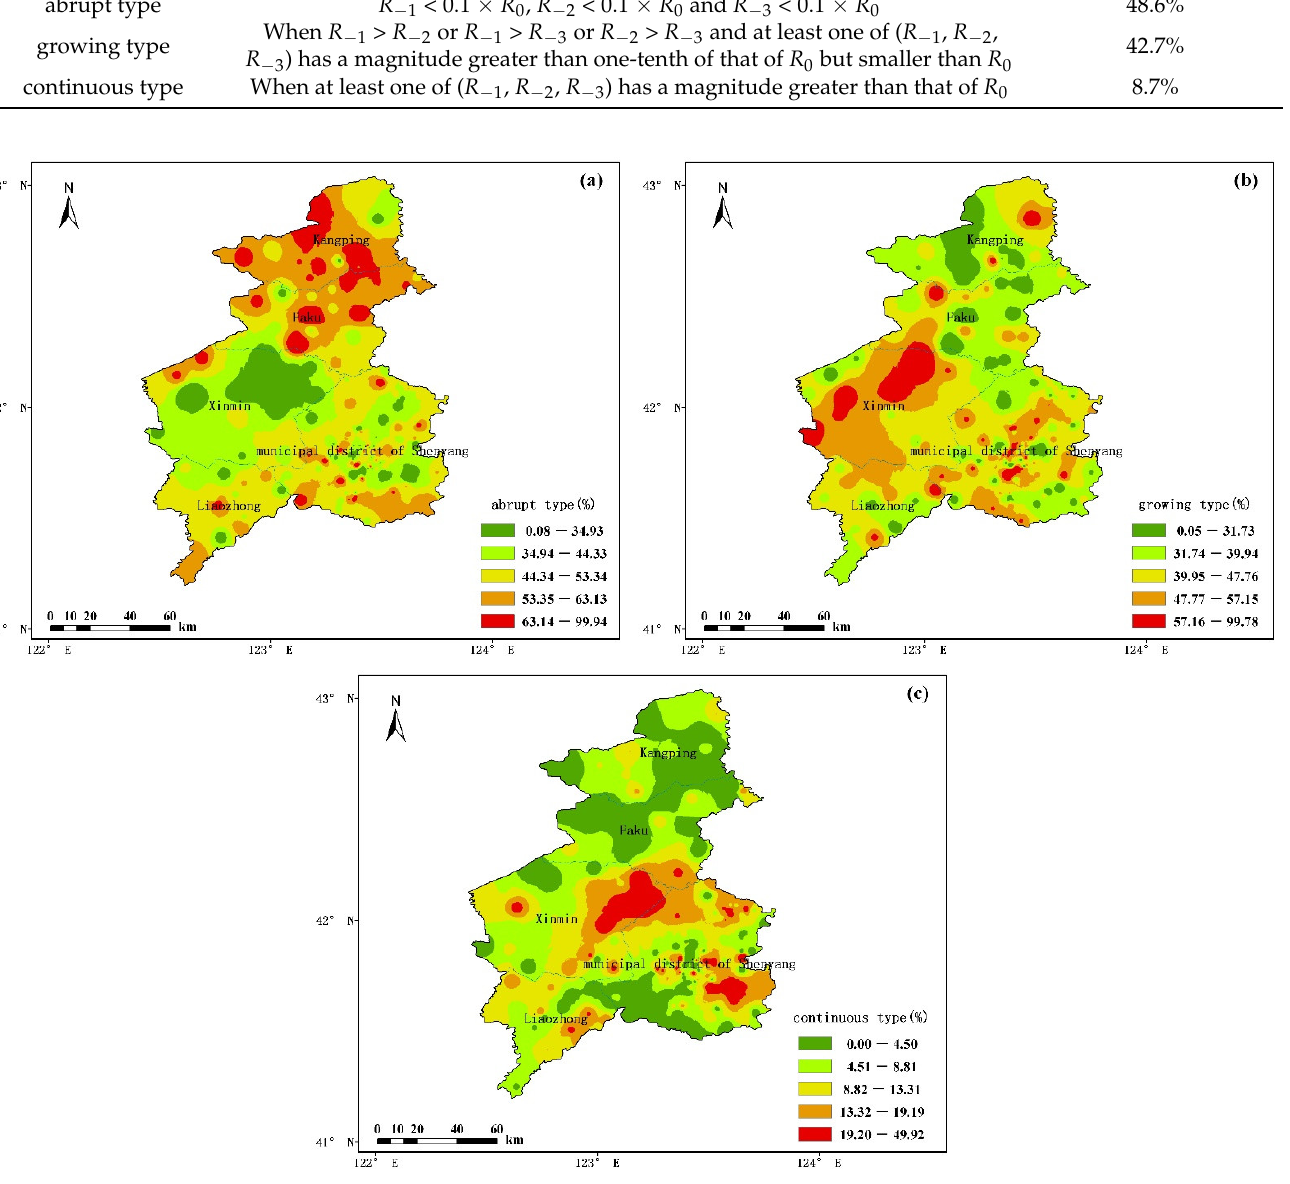
Table 4. Classification criteria and proportions of different types of ExHP events in Shenyang.